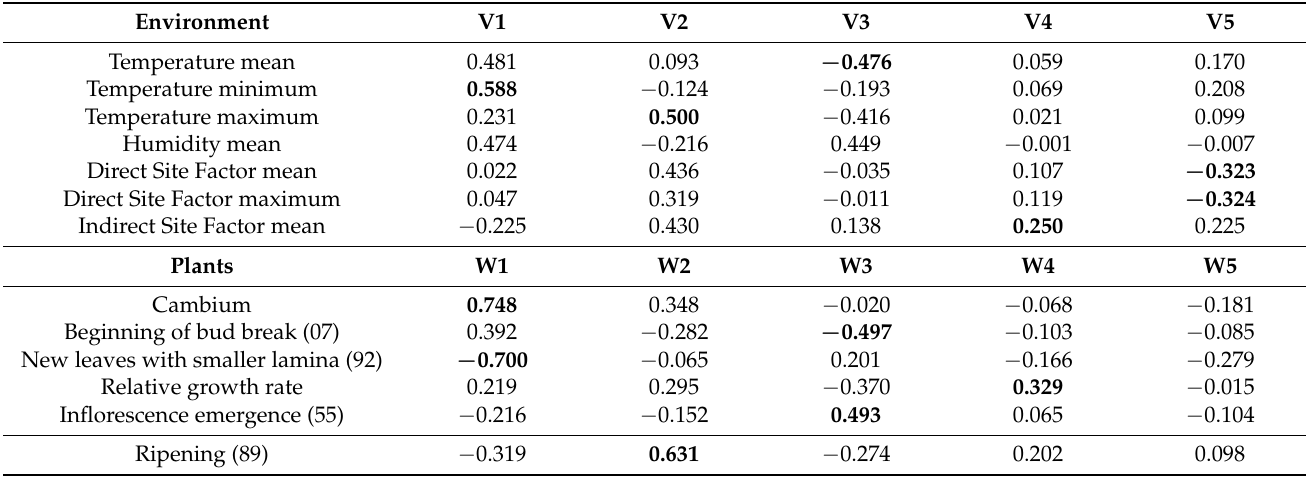
Table 6. Canonical cross-loadings of the first five pairs of canonical variables of environment with cambium and phenology of Ribes ciliatum . Bold indicates the environmental or plant variables with the highest